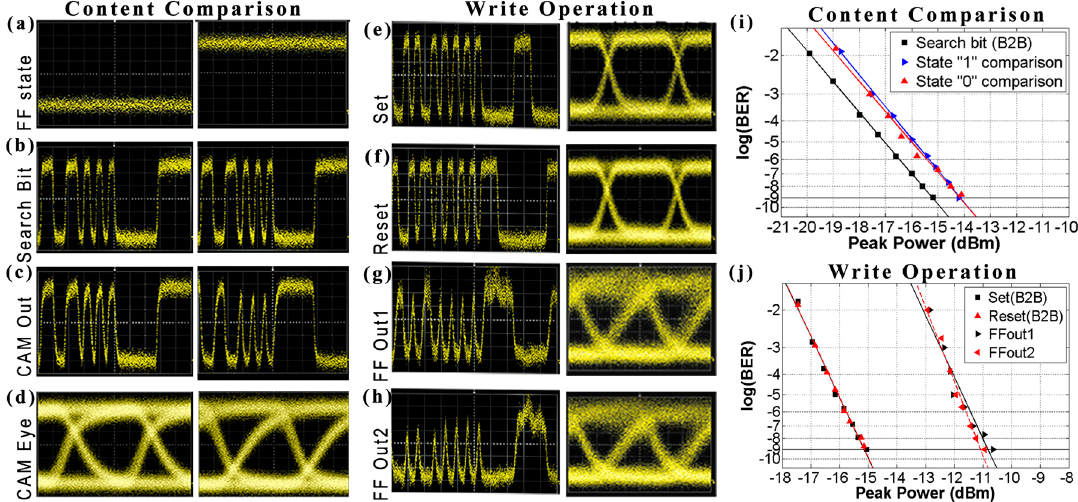
Figure 6. Experimental results of the optical CAM cell demonstration at 10 Gb/s: Comparison operation: time traces (200 ps/div) of ( a ) CAM cell stored bits; ( b ) search bits; ( c ) CAM outputs and ( d ) output eye diagrams (15 ps/div). Write Operation: Time traces at 10 Gb/s (300 ps/div) their corresponding eye diagrams (20 ps/div) of ( e ) the Set ; ( f ) the Reset ; ( g ) FFOut1 and ( h ) FFOut2; and BER measurements of ( i ) the Content Comparison and ( j ) the Write operation.